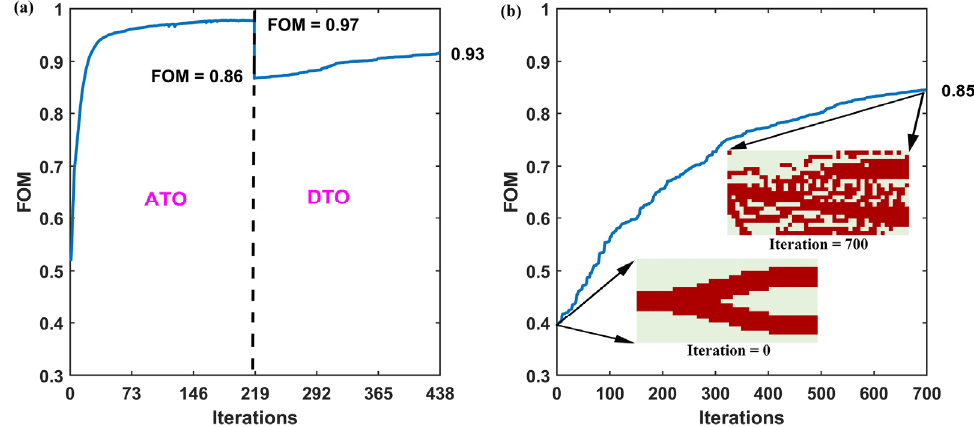
Figure 2. The optimization curves for ( a ) ADTO method and ( b ) DBS method.